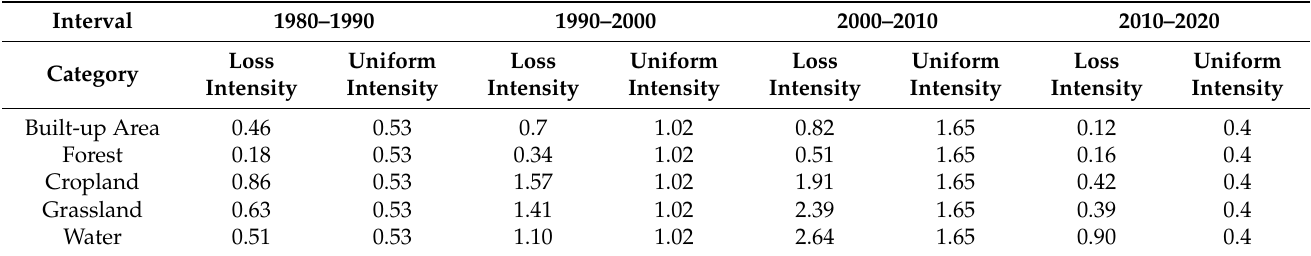
Table 19. Category-level Loss Intensity.